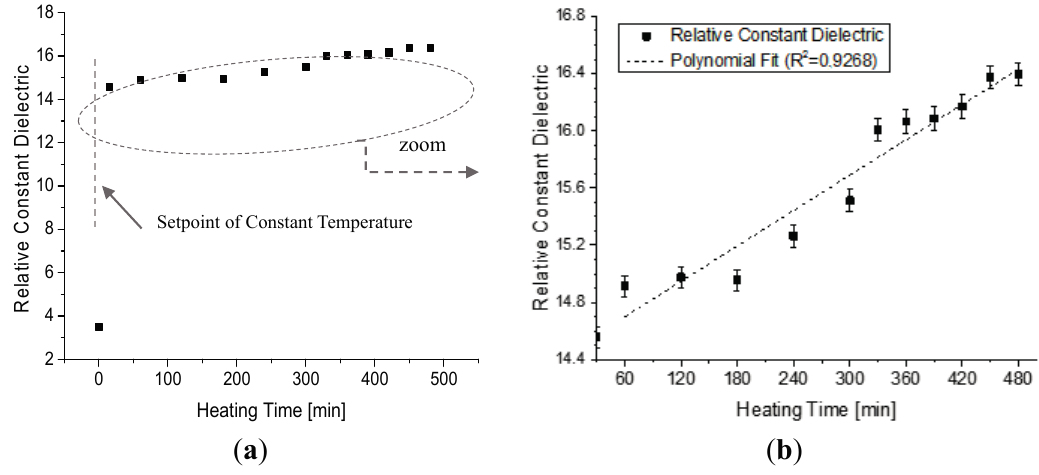
Figure 7. Variation of the Dielectric Constant in relation to time for a soybean oil sample kept at the constant temperature of 180 °C. ( a ) Experimental data of all the heating process since 20 °C; and ( b ) zoom of the data after setpoint of constant temperature.